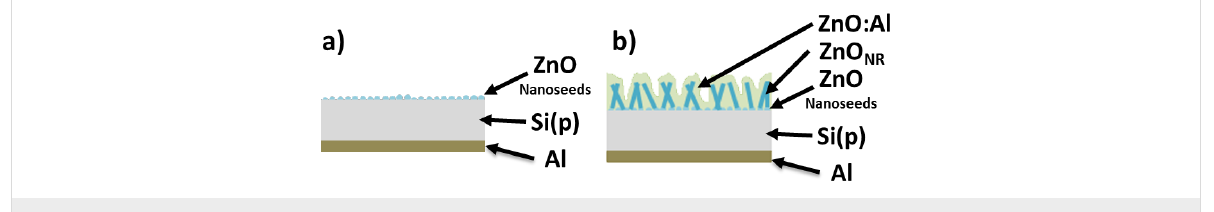
Figure 1: Schematic drawings of the investigated solar cells structure based on zinc oxide nanorods (not to scale).